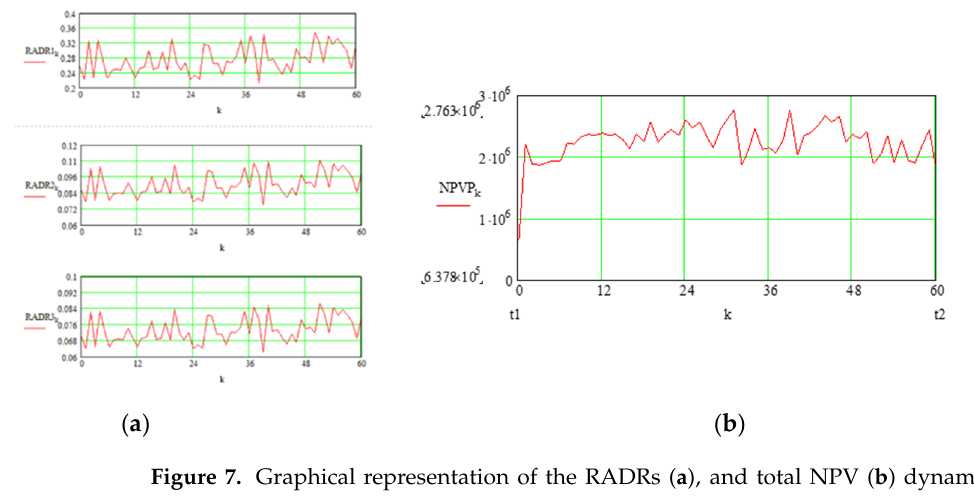
Figure 7. Graphical representation of the RADRs ( a ), and total NPV ( b ) dynamics for Scenario B5 (m = 1.3, σ = 0.20; term structure of the interest rate not considered; interest rate seasonal rate fluctuations not considered).